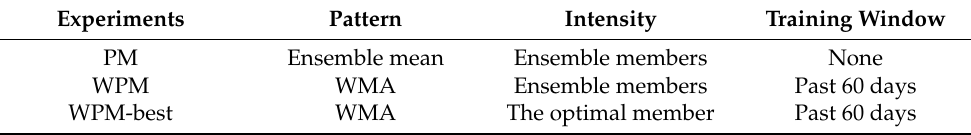
Table 4. Design of the sensitivity experiments.